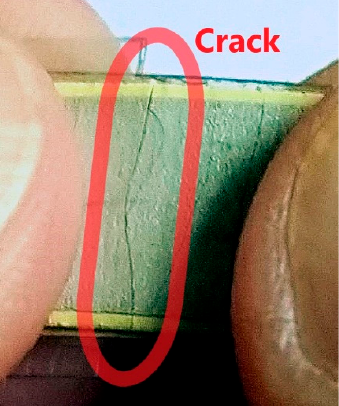
Figure 1. A crack in piezoceramic layer due to operation in high oscillation amplitude (@ 4 mm).